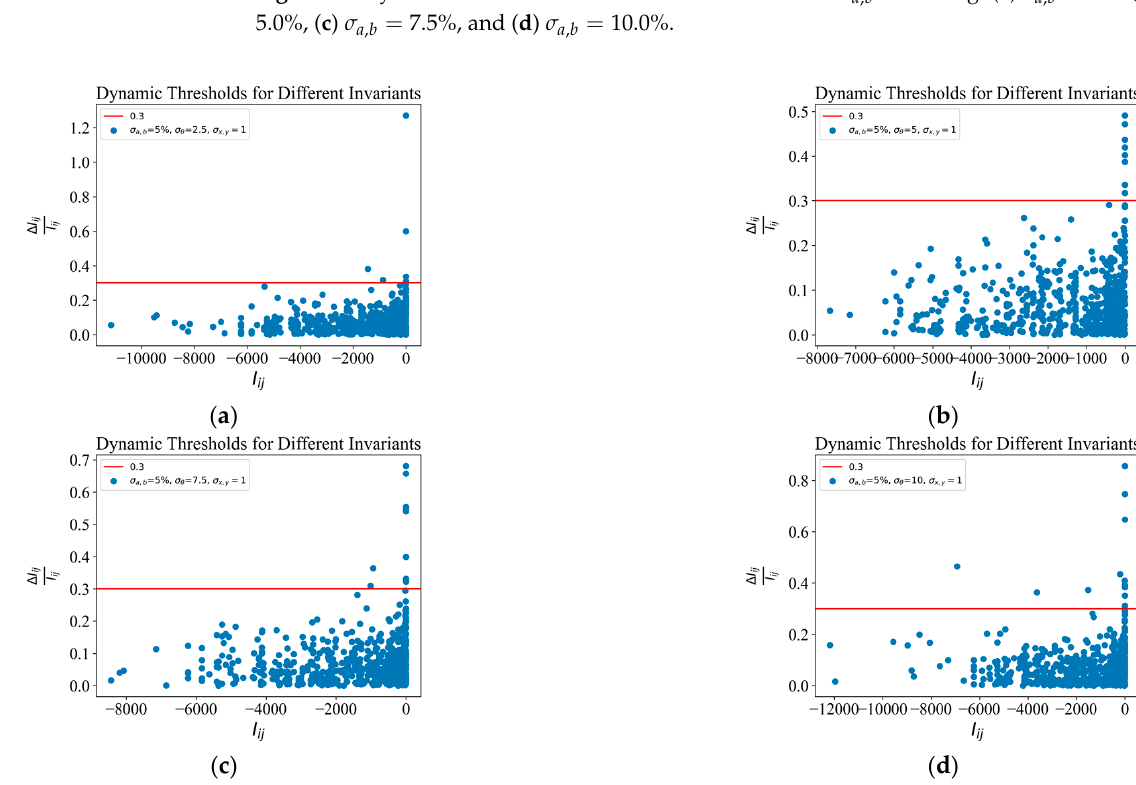
Figure 13. Dynamic thresholds for different invariants with σ (cid:3087) increasing: ( a ) σ (cid:3087) = 2.5 , ( b ) σ (cid:3087) = 5.0 , ( c ) σ (cid:3087) = 7.5 , and ( d ) σ = 10.0 .